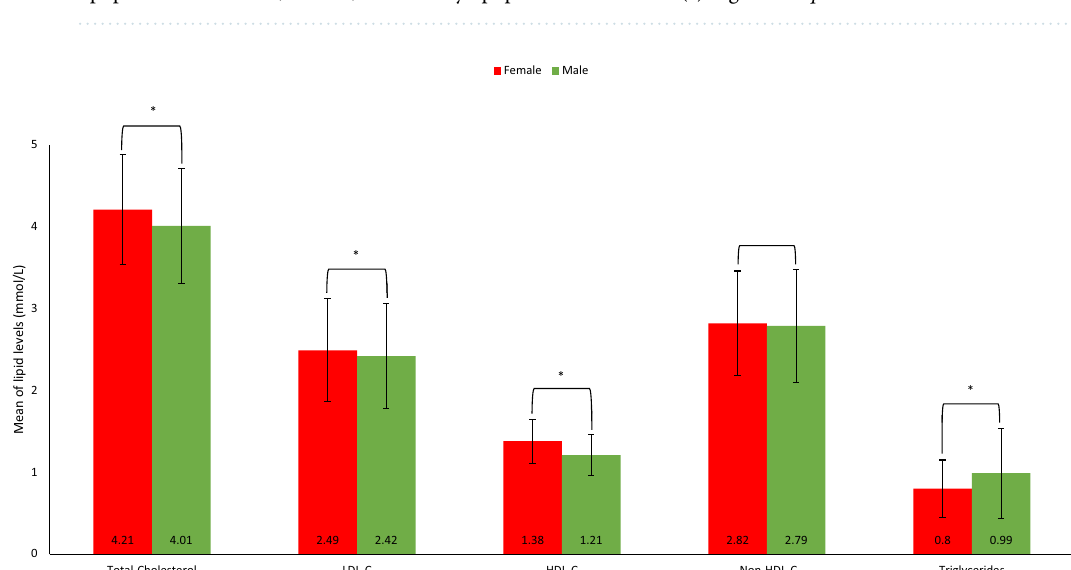
Figure 2. Mean and SD of lipid profile parameters according to gender. Abbreviations: HDL-C, high-density lipoprotein cholesterol; LDL-C, low-density lipoprotein cholesterol; P, P value; SD, Standard deviation. (*): significant p